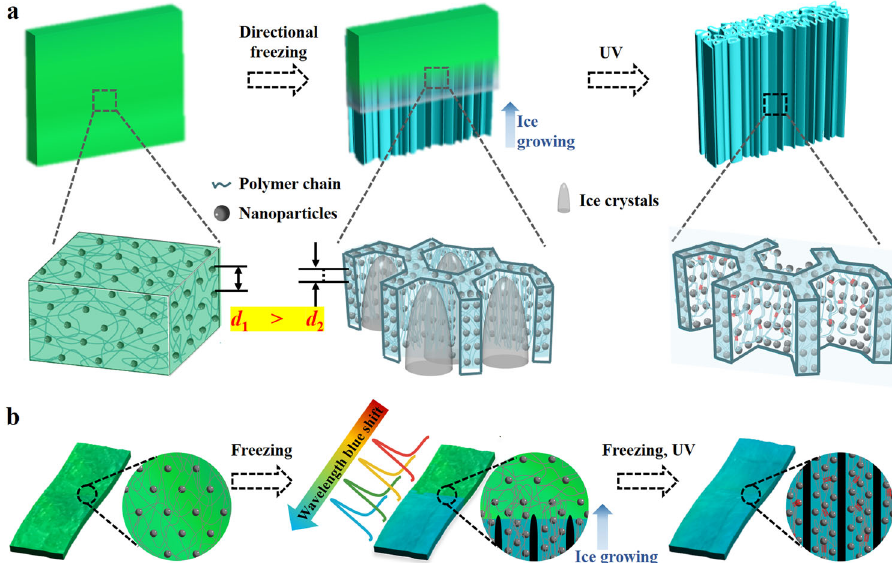
Fig. 1 Principle of wavelength blue shift and fabrication route of ice-templated structural color fi lms. a Schematic illustration of self-assembling nanoparticles based on ice-templating technology. b Scheme of the structural color fi lm prepared by freeze-photopolymerization